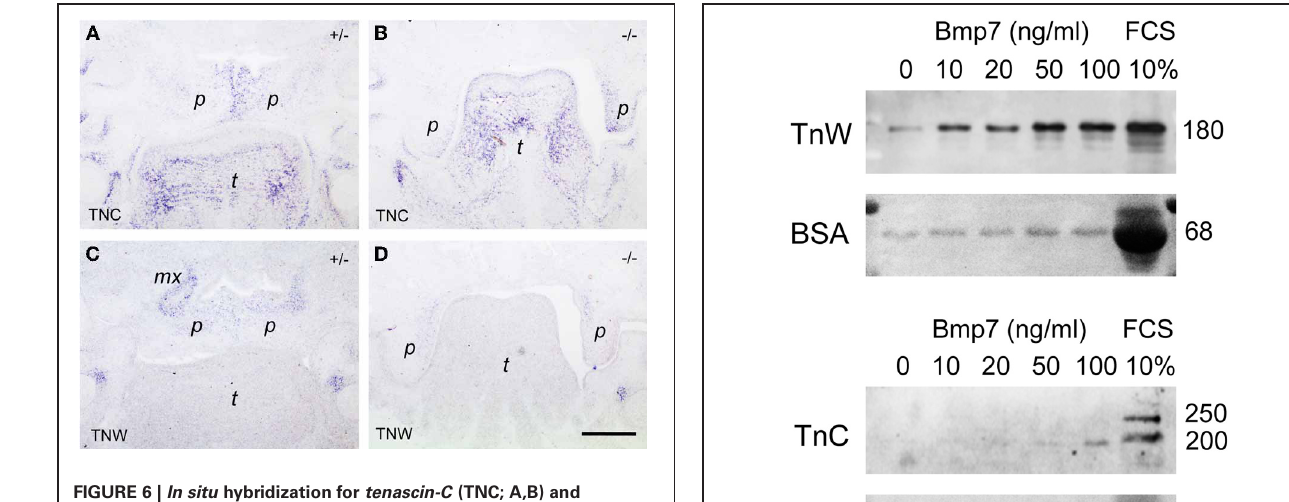
FIGURE 6 | In situ hybridization for tenascin-C (TNC; A,B) and tenascin-W (TNW; C,D) respectively, on frontal sections through the heads of E14.5 Bmp 7 + / − (A,C) and Bmp 7 − / − (B,D) mouse embryos. In